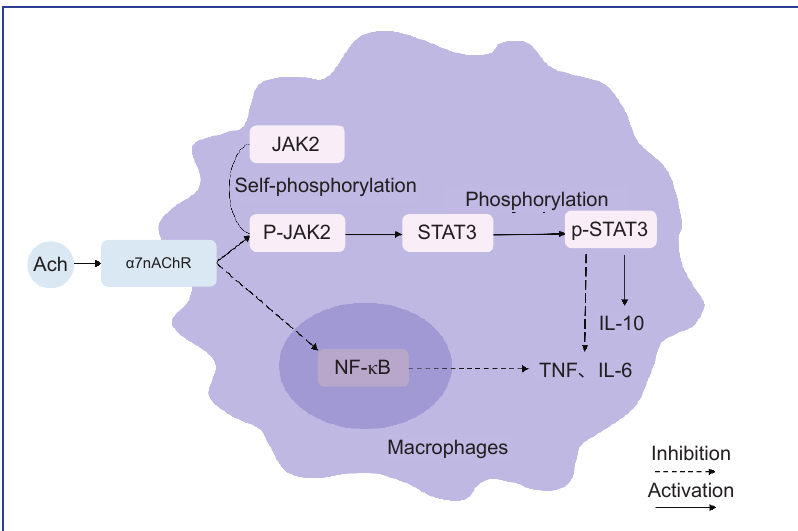
Figure 2 The molecular mechanism of CAP activation regulating inflammatory cytokines release.